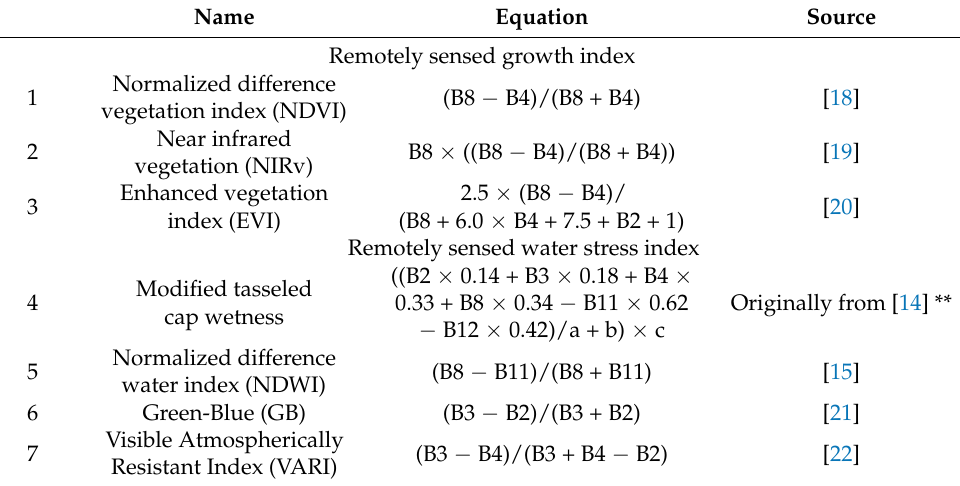
Table 2. Remotely sensed crop growth and water stress indices as calculated from Sentinel-2 bands *.